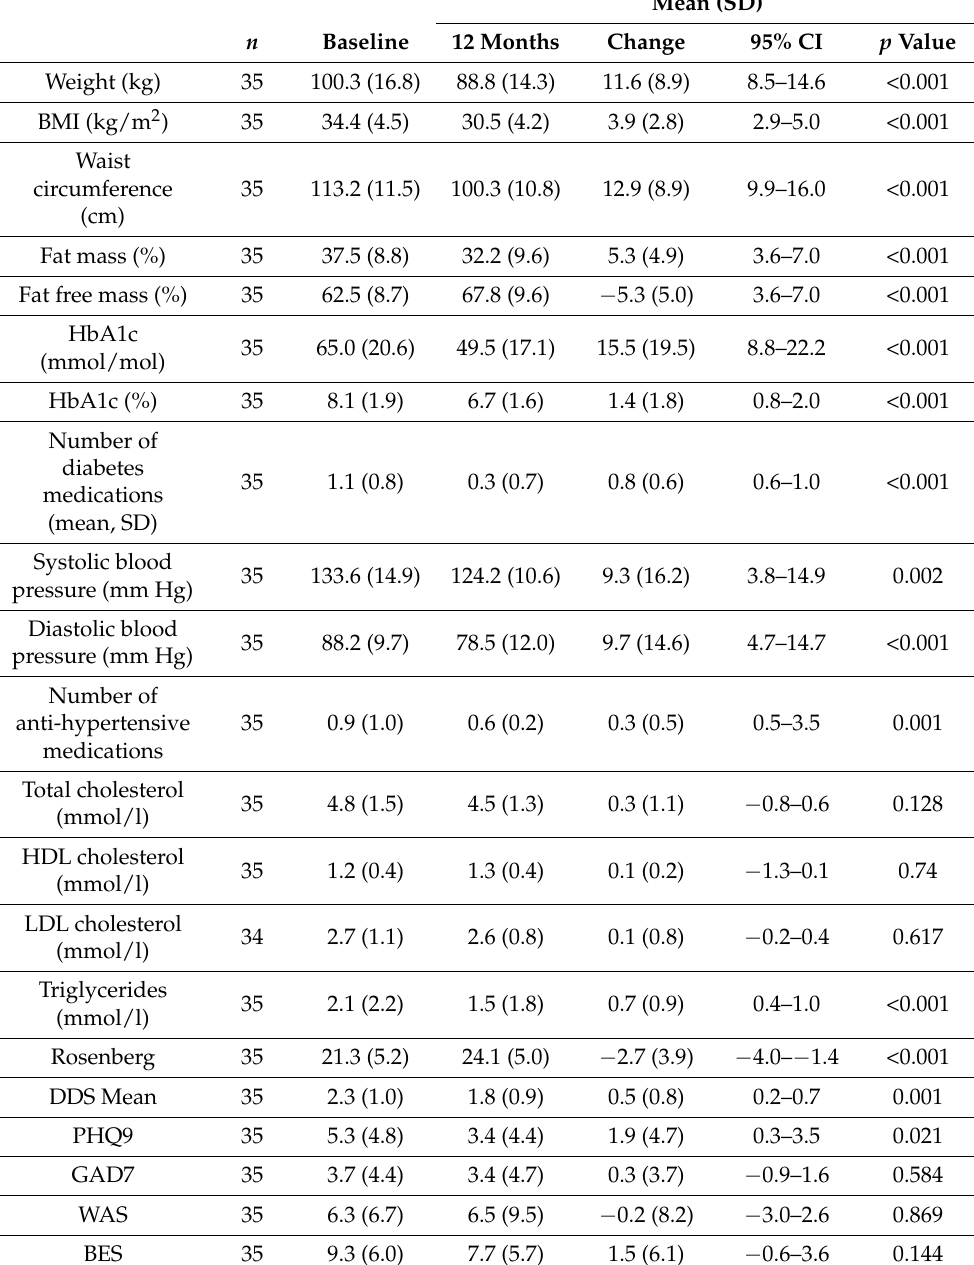
Table 2. Summary of results in participants: key outcomes at 12